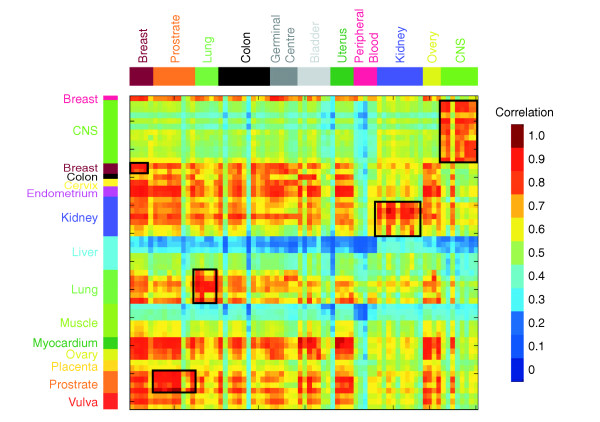
Correlation matrix between all normal samples from two studies. The gene-expression profiles of each normal tissue sample were compared to all other normal tissue samples from the other dataset by measuring the correlation across all genes. The normal samples from Hsiao et al. [17] are presented along the y-axis and samples from Ramaswamy et al. [16] along the x-axis. The correlation matrix displays each pairwise comparison and each entry is color-coded according to the scale bar to the right of matrix. Black rectangles highlight correlation values between the samples from the same tissues in the two different datasets.